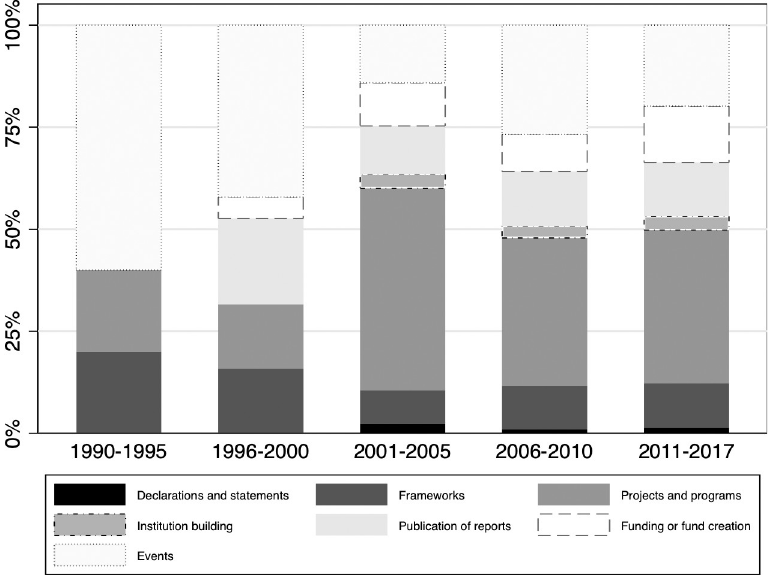
Fig 2. Proportion of the number of IO adaptation activities in seven categories to the total number of adaptation activities in a five-year period, 30 IOs, 1990–2017. Notes: Five-year averages, with the exception of the final period which is a six-year average. Source: IO Engagement